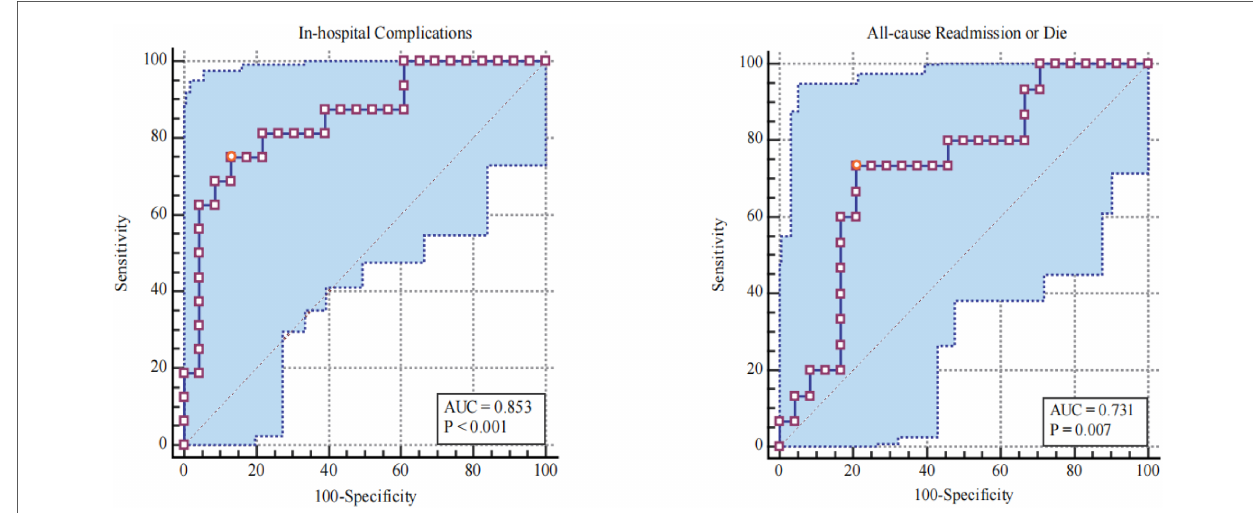
FIGURE 1 Receiving operating characteristic curves and corresponding AUCs for